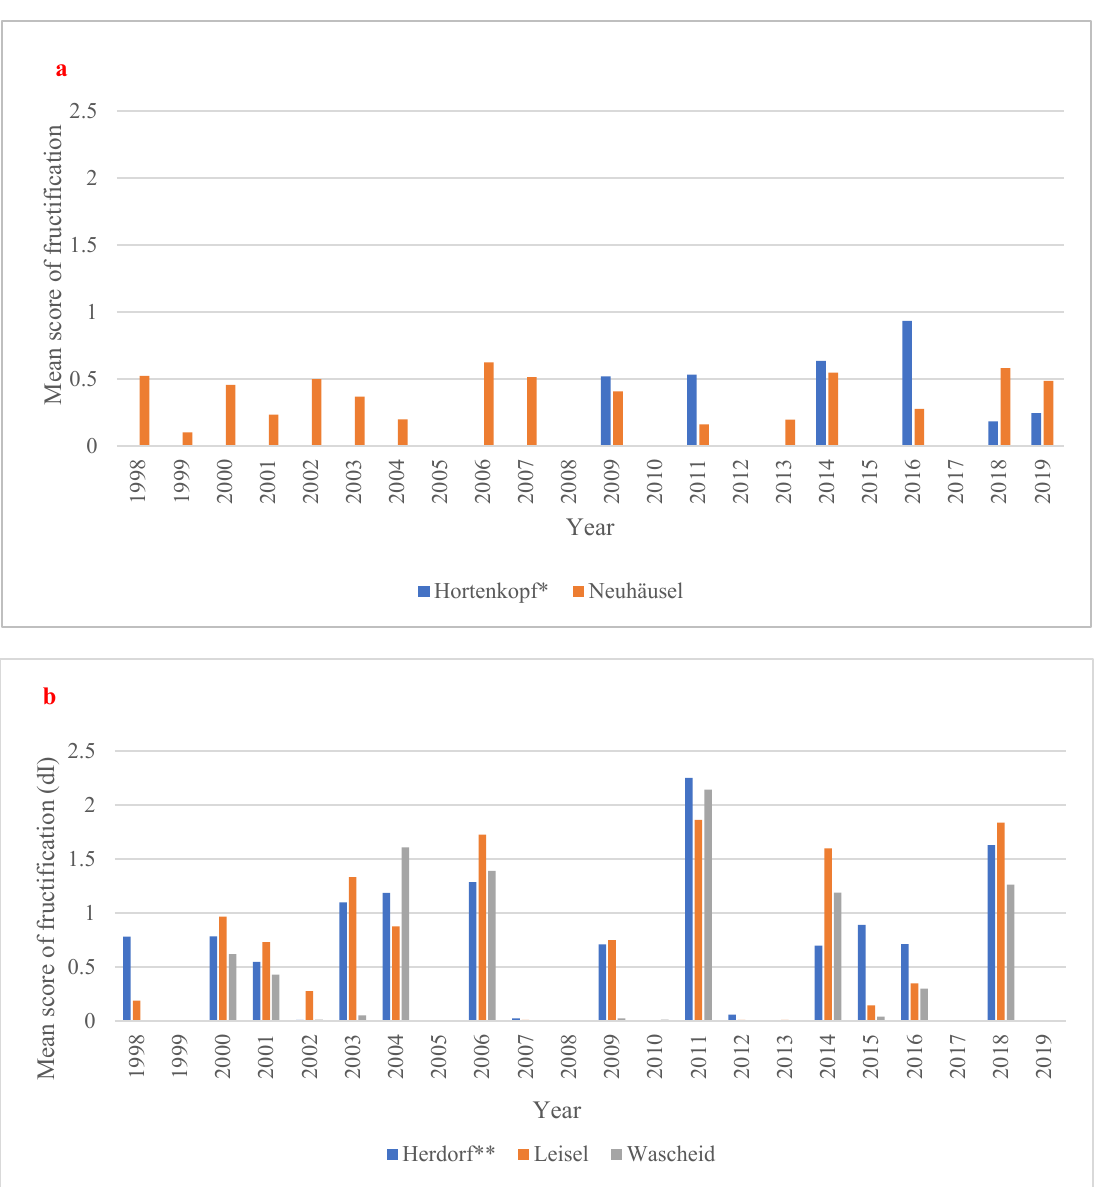
Figure 3. Mean score of fructification (0 = absent, 1 = scarce, 2= common, and 3 = abundant fructification, dimensionless) for ( a ) European beech and ( b ) Norway spruce sites over the time period 1998-2019. * no data fructification data from 1998 to 2007 and 2012 and 2013 available. ** no fructification data for 2019 available.